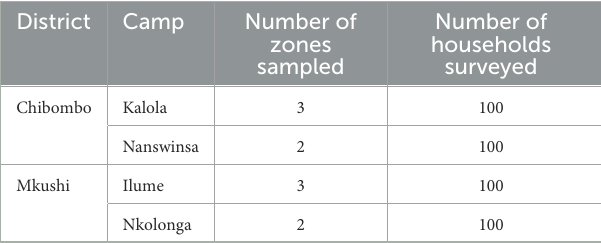
Number of zones households sampled surveyed